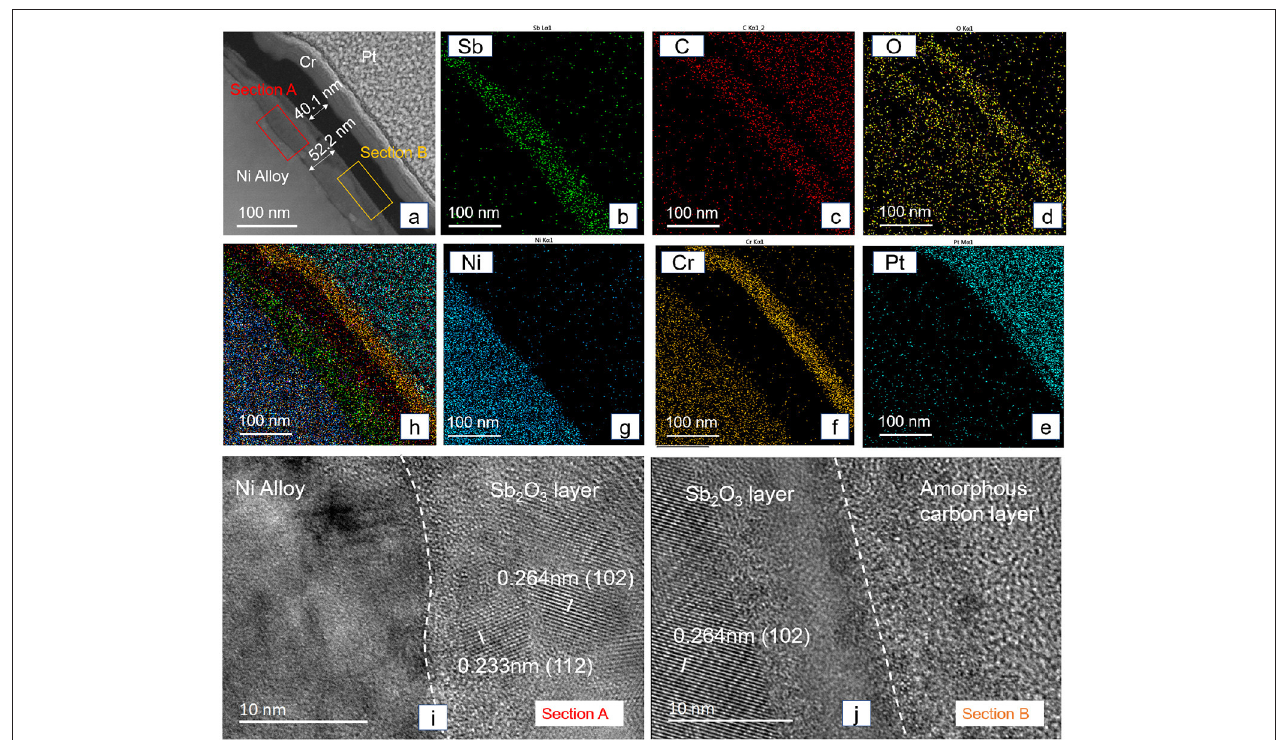
FIGURE 10 | Cross-sectional TEM image of the Sb 2 O 3 -MSH/C surface after the test under 300 ◦ C (a) , the EDS elemental mapping of the cross-sectional area (b–h) , and High-resolution TEM image is taken from the interface area of different layers (i, j) , which is also marked as section A and section B in (a) . The Pt and Cr protective layers were deposited to protect the tribofilm from the damage during TEM specimen